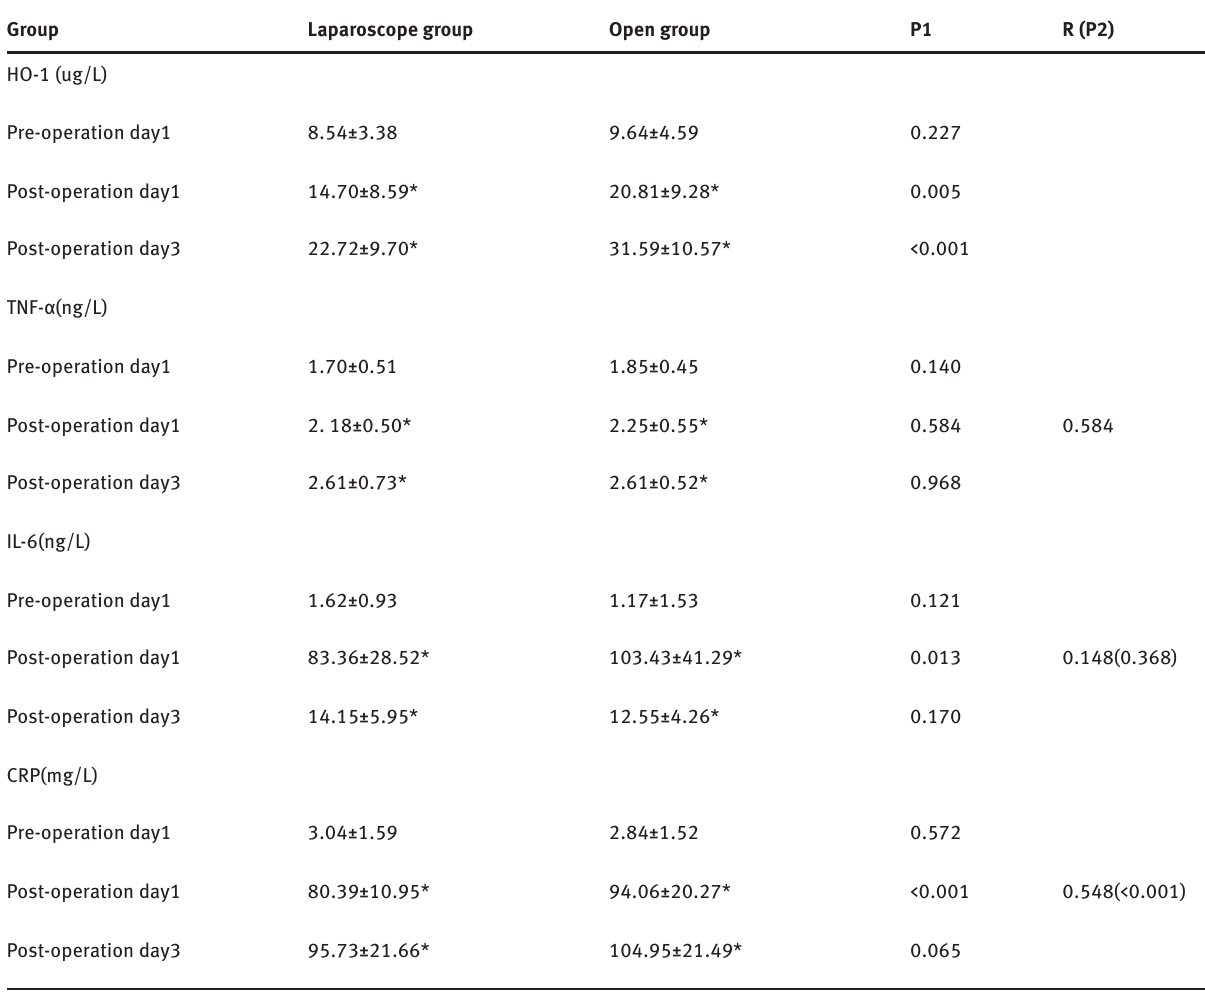
Table 2: Comparison of indexes in different times between two group patients